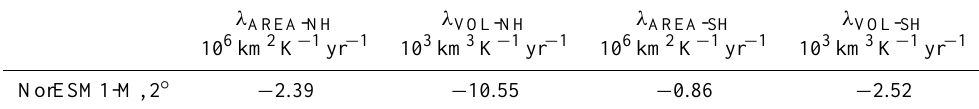
Table 4. Global gross feedback response ( λ X ) in ( X = ) yearly averaged sea-ice area (AREA, 10 6 km 2 yr − 1 ), and volume (VOL, ( 1X ) with respect to the corresponding annual surface air temperature change ( 1T ) after abrupt 4 × CO 2